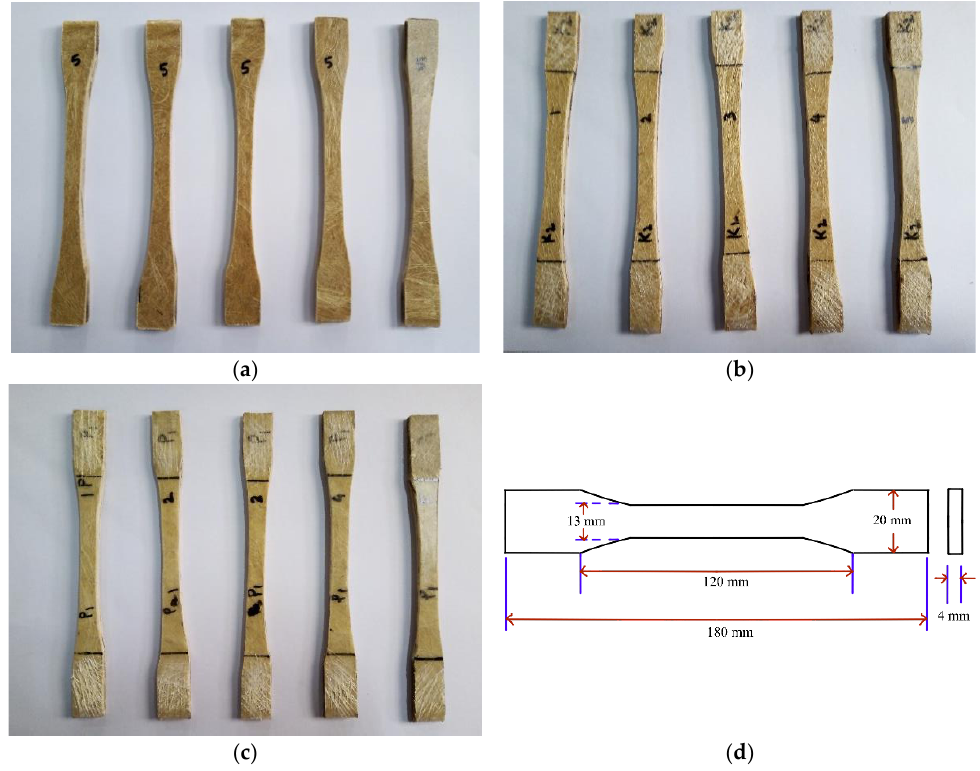
Figure 3. Composite specimens with ( a ) jute ( b ) kenaf, ( c ) PALF fibers before tensile testing and ( d ) specimen dimension: 180 mm × 20 mm × 4 mm.